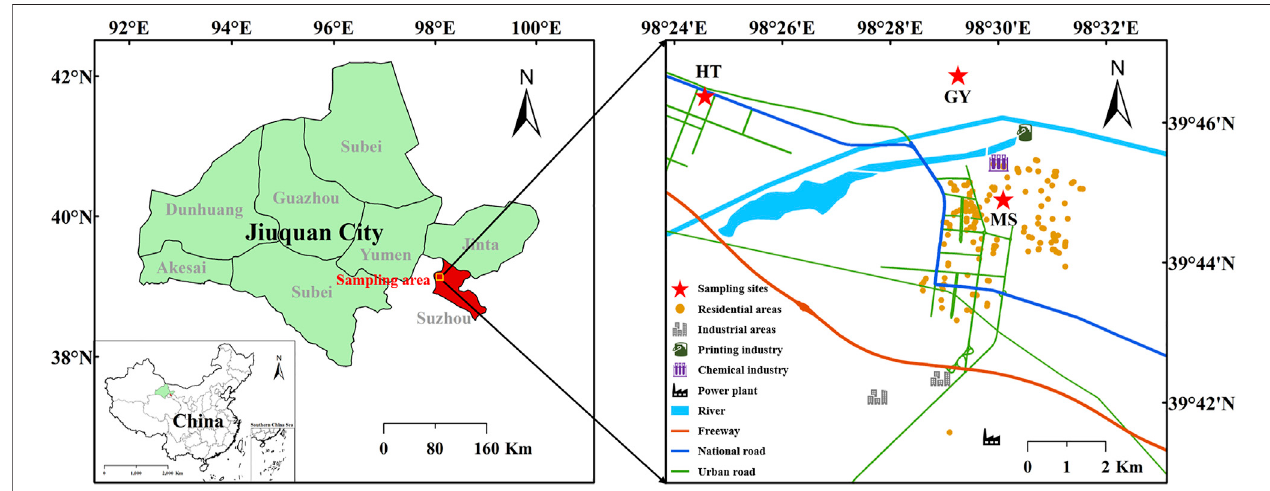
FIGURE 1 | Geographical location of study area as well as sampling sites in Jiuquan city. SZ, Suzhou District site; HT, High-tech Zone site; MS, Meteorological Station